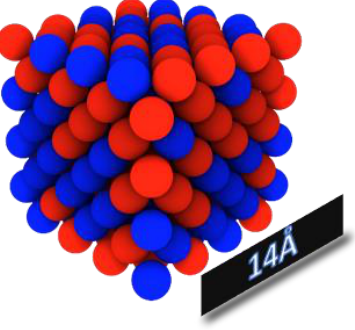
Figure 1. FCC structure of NiAg with 256 atoms and a 50/50 composition.